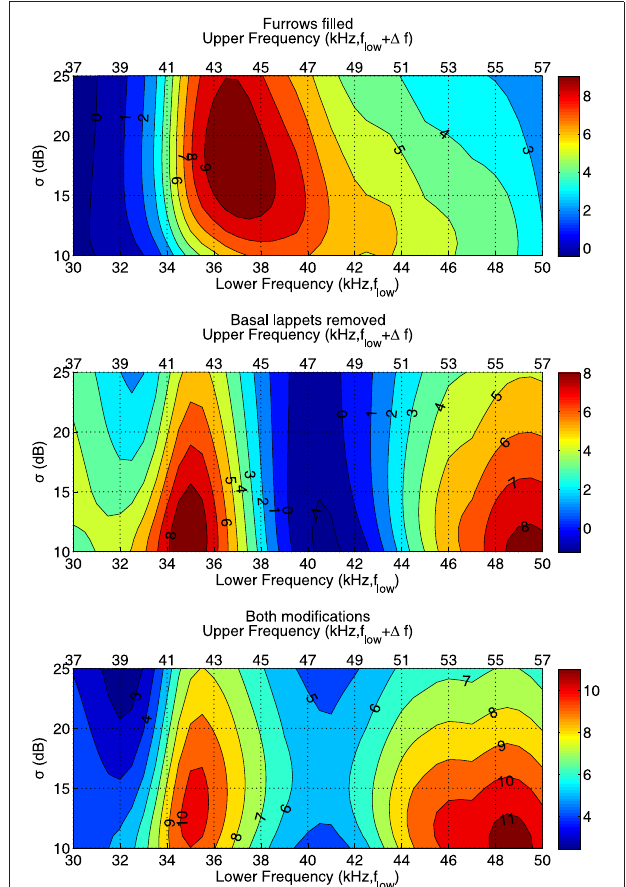
FIGURE 5 | The expected angular error E ( ζ ) (in degrees) between the strongest echo and the target echo averaged across the frontal hemisphere for different frequency ranges and values of σ and different noseleaf models. The lower x-axis depicts the lower frequency of the interval. The upper x-axis shows the upper